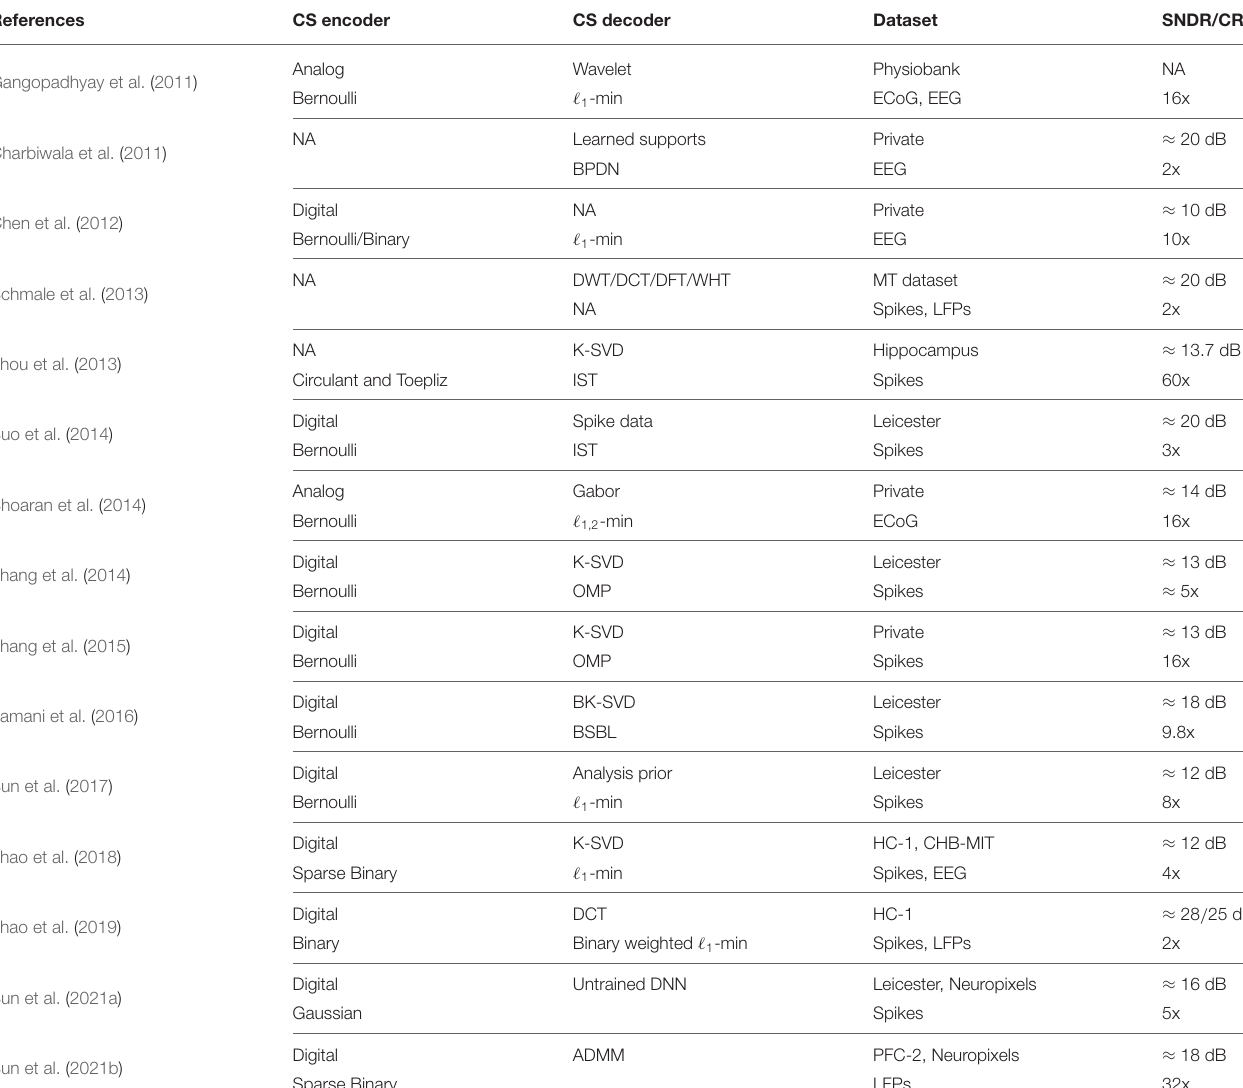
TABLE 1 | Comparison of compressed sensing (CS) methods for neural